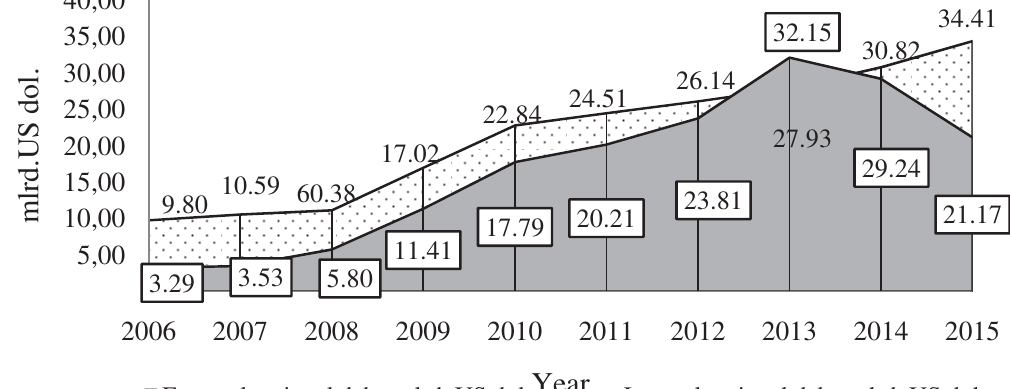
Fig. 4. Dynamics of national debt of Ukraine and its components during 2006-2015, mln US